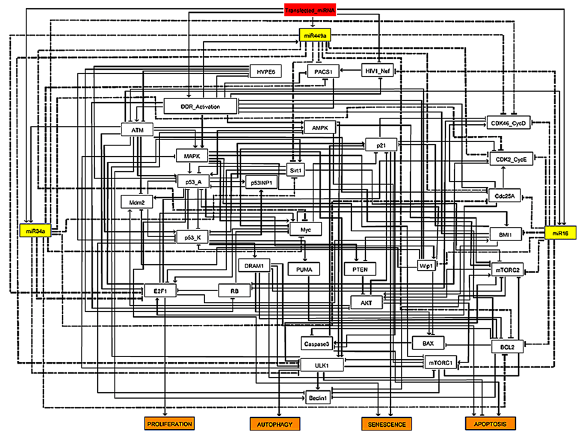
Figure 2. Synthetic gene regulatory network for the functional G1/S checkpoint. Arrows denote activations and hammer-head arcs represent inhibitions, respectively. Dashed hammer-head arcs represent targets of miRNA-34a, miR-449a and miR-16. The yellow rectangular nodes represent miRNAs and the red one denotes transfected miRNAs which induces DNA damage response in HeLa cells. The network outputs are in orange rectangular nodes represents proliferation or autophagy or apoptosis or senescence.